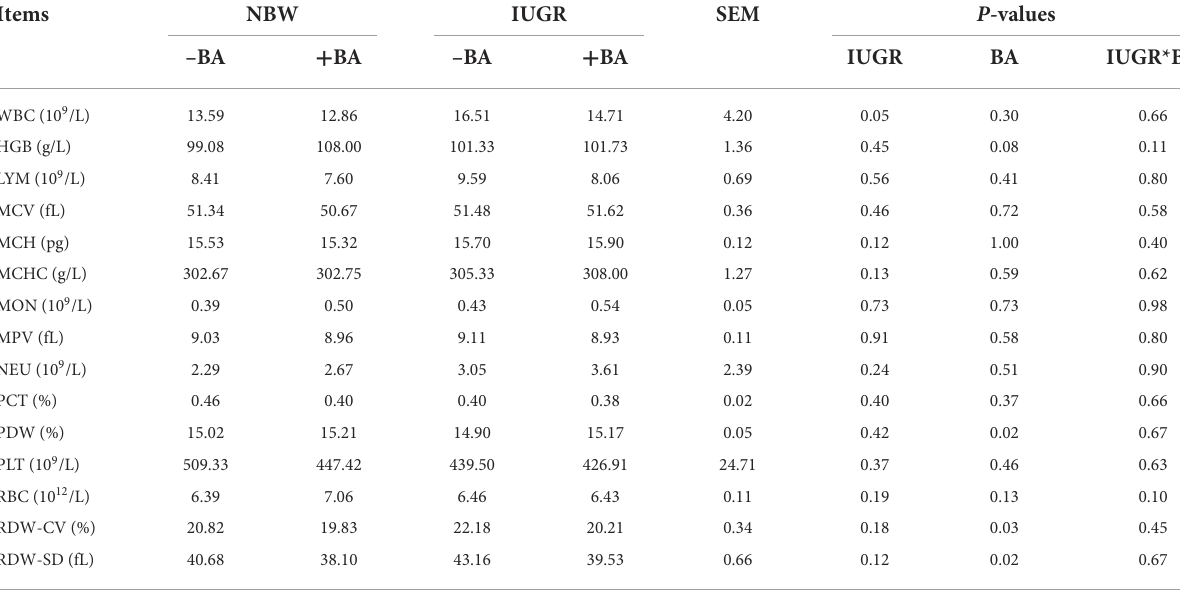
TABLE 2 Effects of dietary bile acid (BA) supplementation on hematological profiles of weaned piglets with NBW and